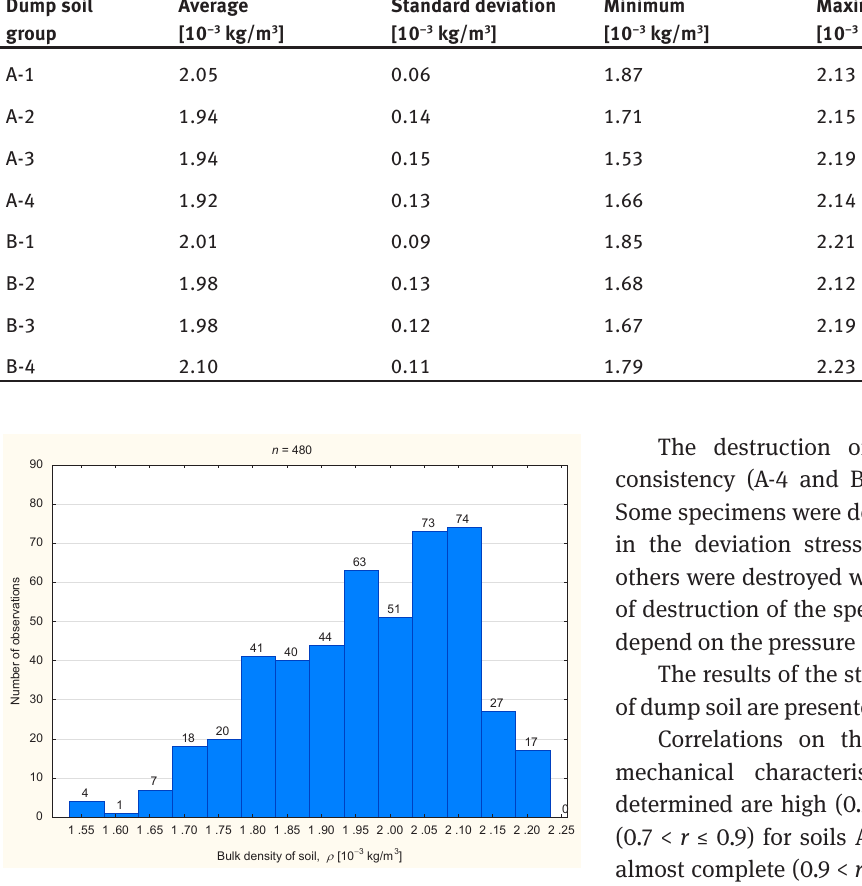
Table 3: Results of bulk density tests of the dump soil in particular soil groups. Dump soil